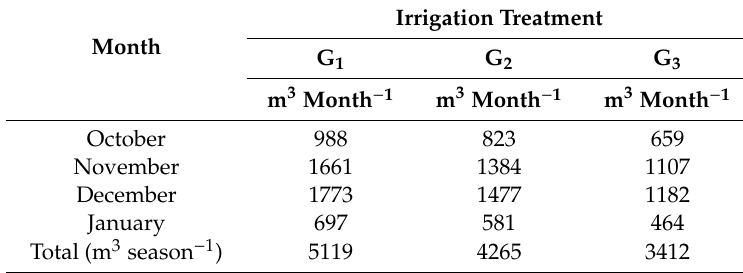
Table 4. Average monthly and seasonal irrigation water supplied to the potato crop. Irrigation Treatment Month G 1 G 2 G 3 m 3 Month − 1 m 3 Month −